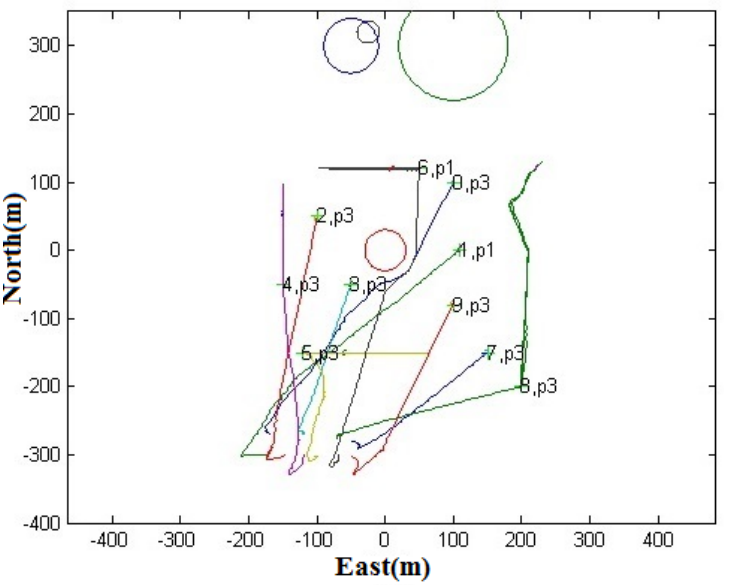
Figure 13. Case 1: Cooperative collision avoidance against static circle obstacle. Symbols “i,pj” represent